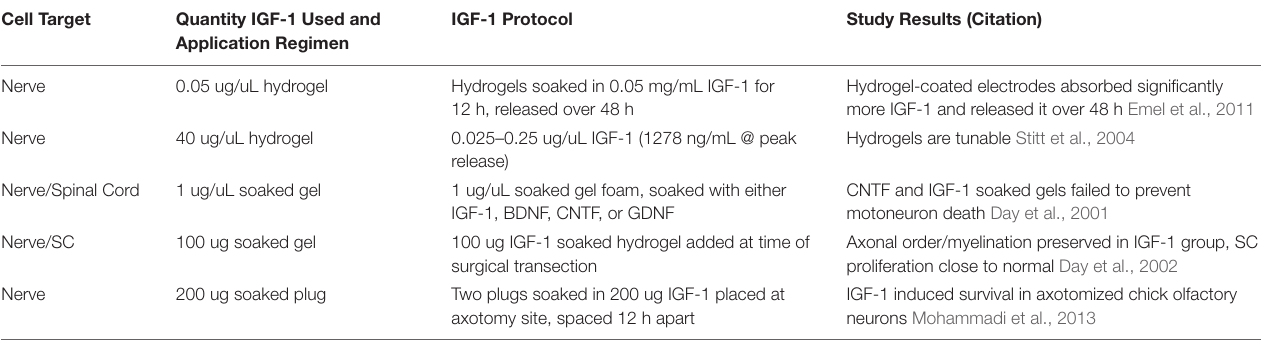
TABLE 6 | In vivo studies using IGF-1-eluting hydrogels for local administration (BDNF, brain-derived neurotrophic factor; CNTF, ciliary neurotrophic factor; GDNF, glial cell line-derived neurotrophic factor). Cell